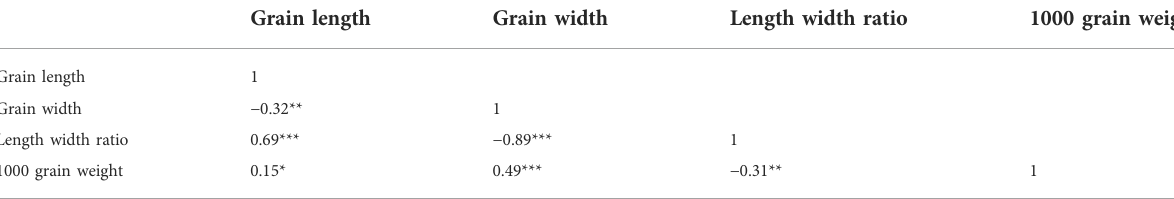
TABLE 1 Correlation coef fi cient by Pearson ’ s product-moment